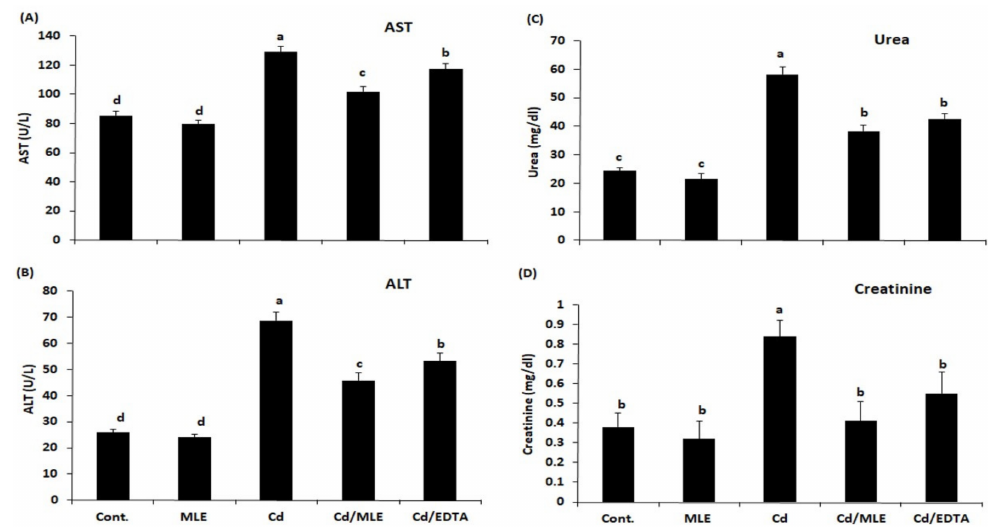
Figure 2. Serum AST, ALT, urea, and creatinine parameters in the different groups under study. ( A ) AST activity, ( B ) ALT activity, ( C , D ) urea, and creatinine levels. Tukey pairwise comparison; means that do not share a letter are significantly different.